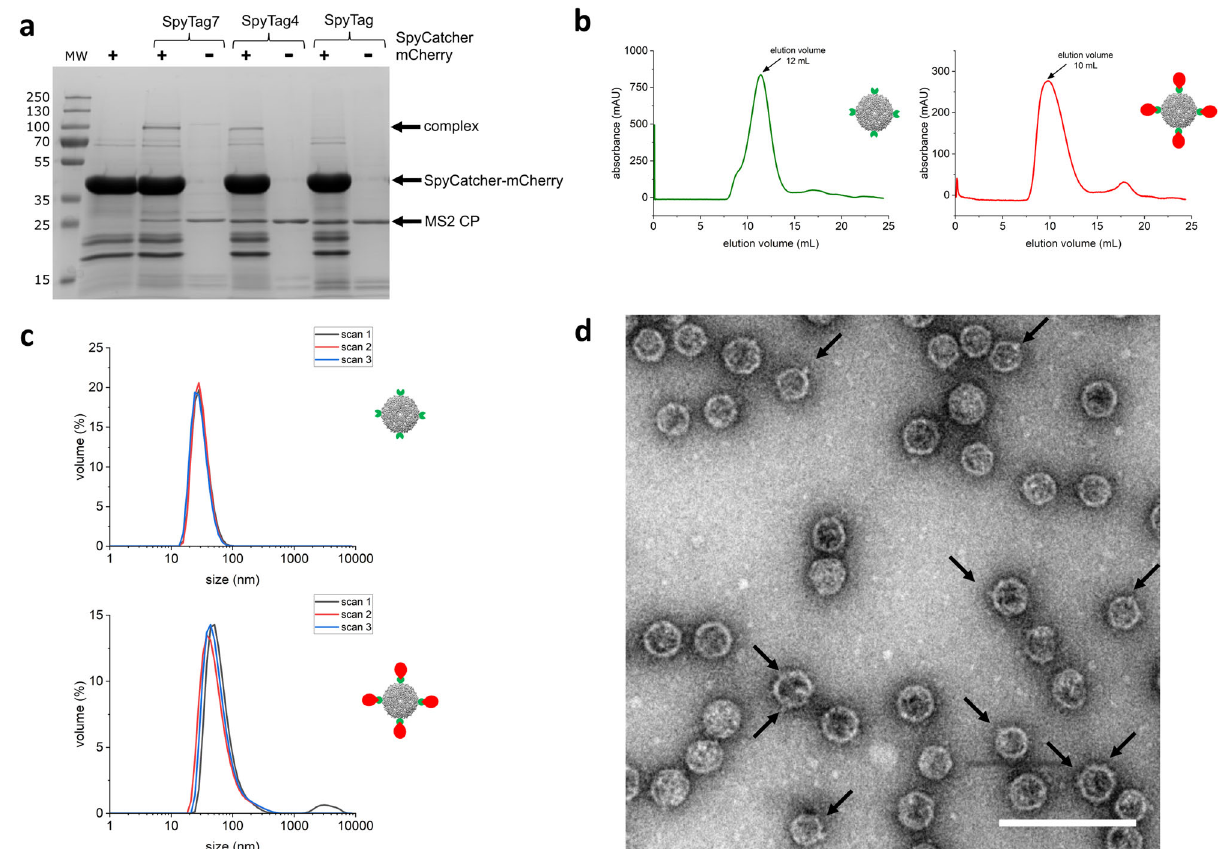
Fig. 3 MS2 VLP decoration with the SpyCatcher – mCherry protein. a SDS-PAGE gel showing the interaction of the SpyCatcher – mCherry protein with different versions of the MS2 coat protein fused with SpyTag variants; b Size exclusion elution pro fi les of naked MS2 VLPs (MS2-SpyTag4 left/green) and the same VLPs decorated with SpyCatcher – mCherry (right/red). In both cases, samples were pre-puri fi ed using an ultra fi ltration device with MW cut off 100 kDa. c DLS pro fi les (three independent scans of the same sample) of the SpyTag modi fi ed MS2 VLPs alone (top) and after addition of SpyCatcher – mCherry partner (bottom); d TEM image of SpyCatcher – mCherry decorated MS2 VLPs, with black arrows pointing to the SpyCatcher – mCherry protein on the surface of MS2 VLPs (scale bar: 100